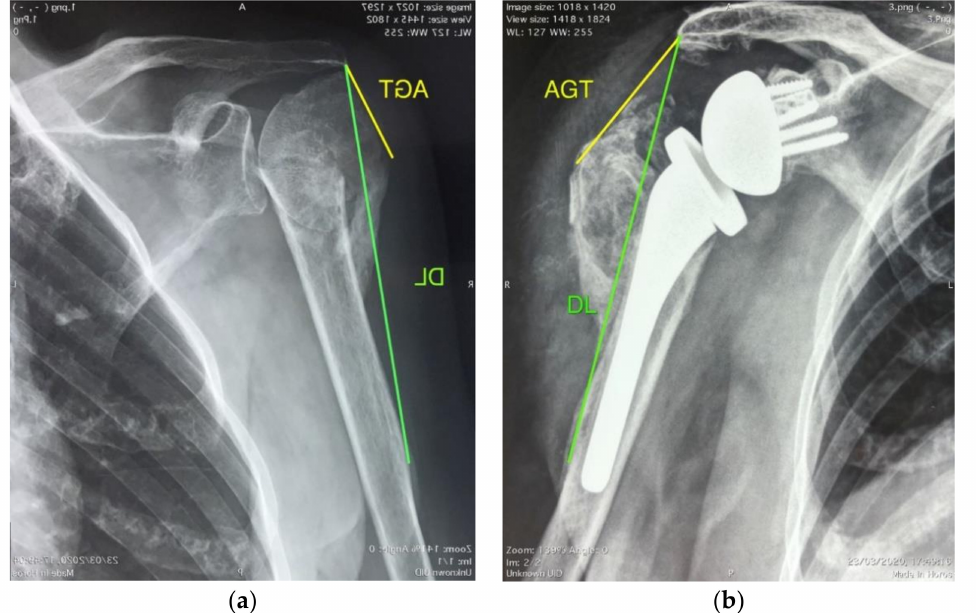
Figure 1. Radiographic acromion to greater tuberosity distance (AGT) and deltoid length (DL); ( a ) preoperative measurement; ( b ) postoperative